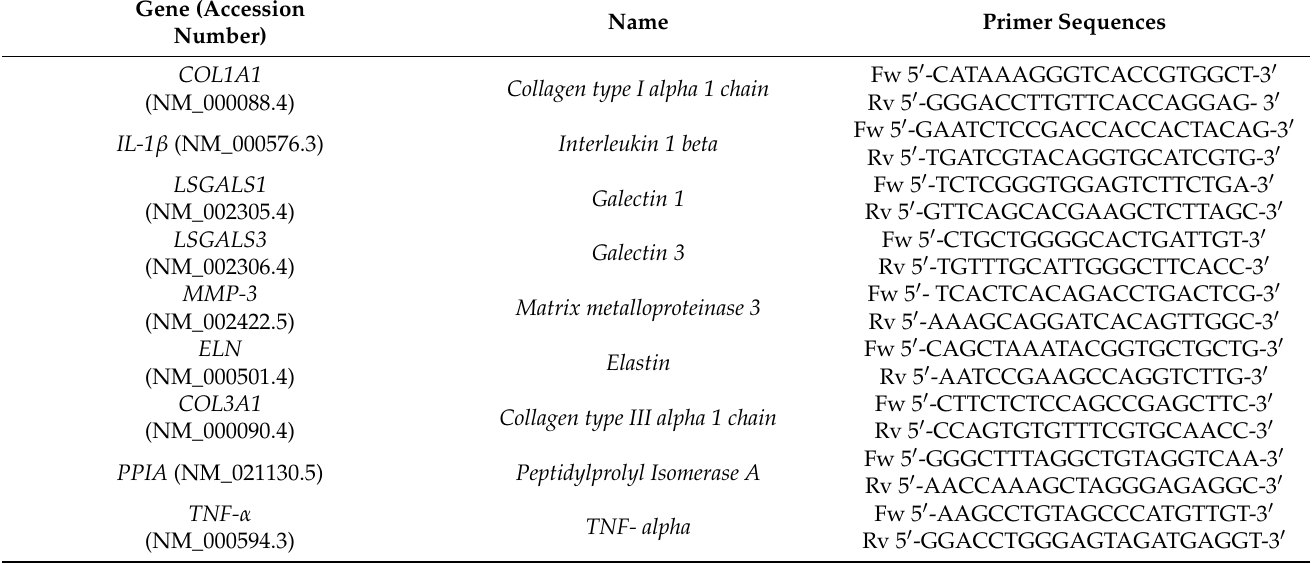
Table 1. Genes studied and primers